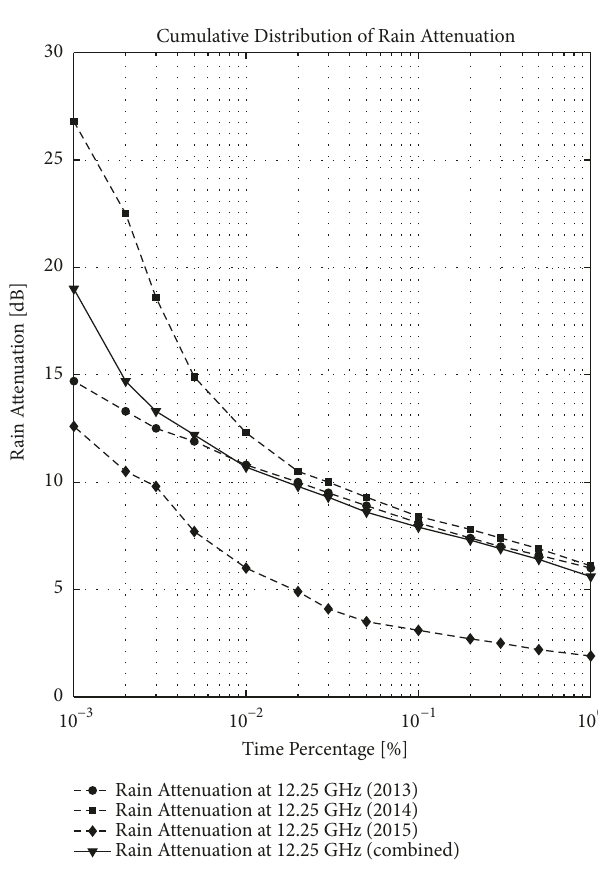
Figure 3: Distribution of Rain attenuation at Mokdong